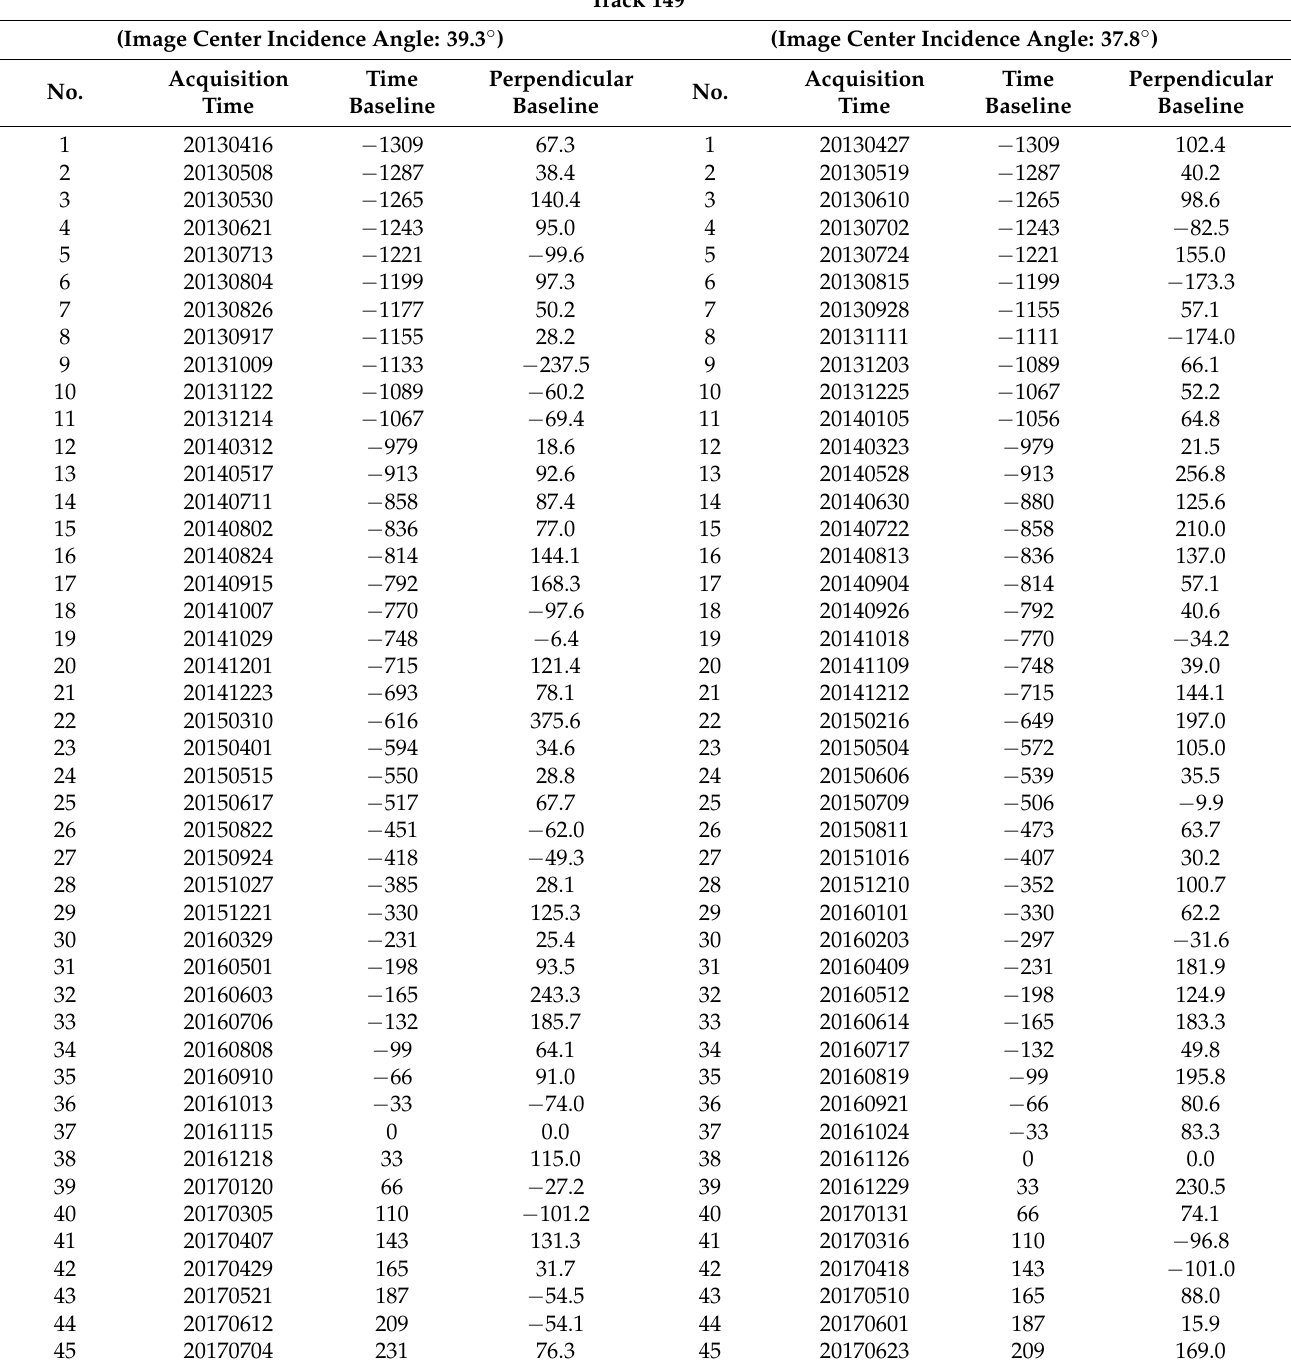
Table 1. Acquisition parameters of TerraSAR-X images. Track 149 (Image Center Incidence Angle: 39.3 ◦ ) (Image Center Incidence Angle: 37.8 ◦